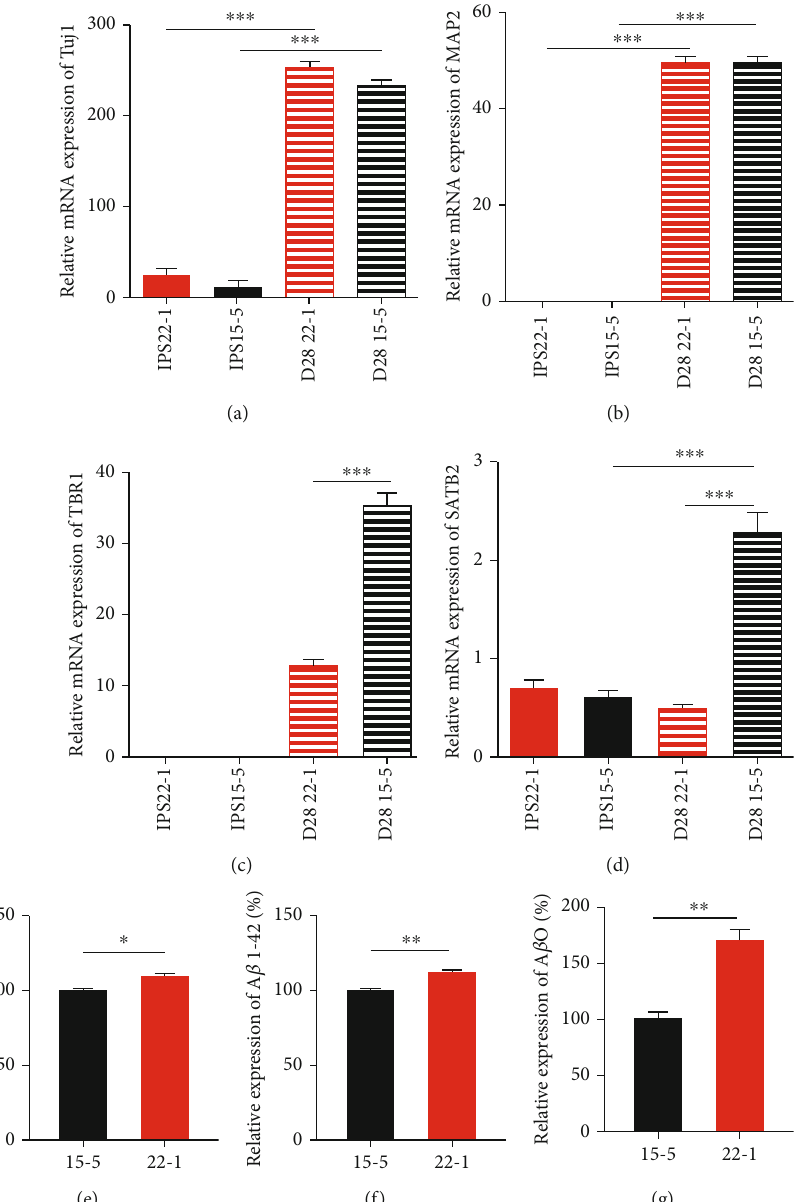
Figure 4: The qPCR results and the determination of beta-amyloid protein. After 28 days of culturing, Tuj1 and Map2 signi fi cantly increased. But there was no signi fi cant di ff erence in expression of neuronal markers Tuj1 and Map2 between iPS-22-1 and iPS-15-5 cell (a, b). However, the expression of cortical neuron markers SATB2 and TBR1 of iPS-15-5 was higher than that of iPS-22-1 (c, d). ∗ P < 0 : 05 , ∗∗ P > 0 : 05 , and ∗∗∗ P < 0 : 01 . n = 3 . The contents of A β 1-40 and A β 1-42 in adherent culture of neurons in AD patients had been higher than those in normal people (e, f). ∗ P < 0 : 05 , ∗∗ P < 0 : 01 . n = 3 . The content of A β O in adherent culture solution of neurons in AD patients had been higher than that of normal people (g). ∗ P < 0 : 05 . n = 3